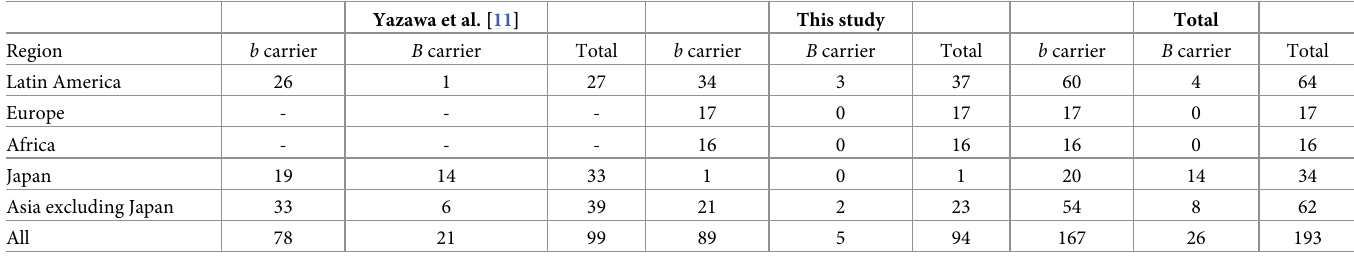
Table 3. Geographic distribution of b and B